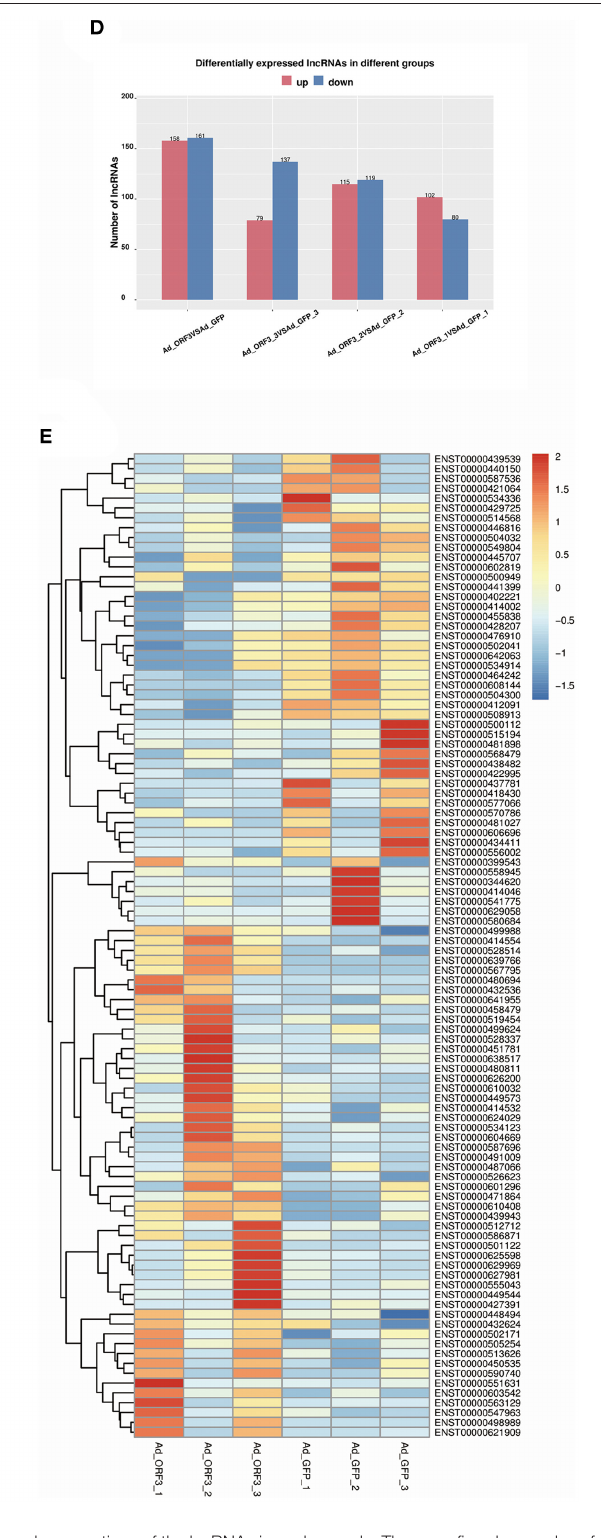
FIGURE 3 | Analysis of differentially expressed lncRNAs. (A) Pie chart of different class code proportions of the lncRNAs in each sample. There are five class codes of lncRNA: j indicates a potentially novel isoform (fragment); i indicates a transfragment falling entirely within a reference intron; o indicates a generic exonic overlap with